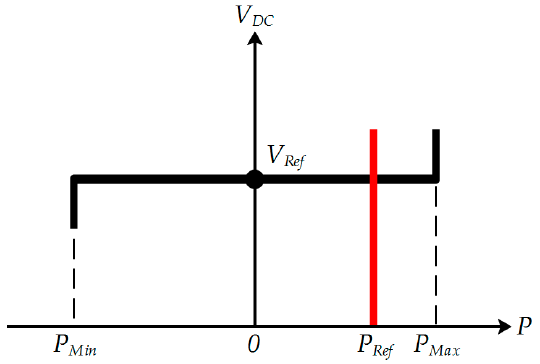
− V DC characteristics of (black) the master converter and (red) the Figure 1. 𝑃 − 𝑉 (cid:3005)(cid:3004) characteristics of (black) the master converter and (red) the slaves Figure 1. P